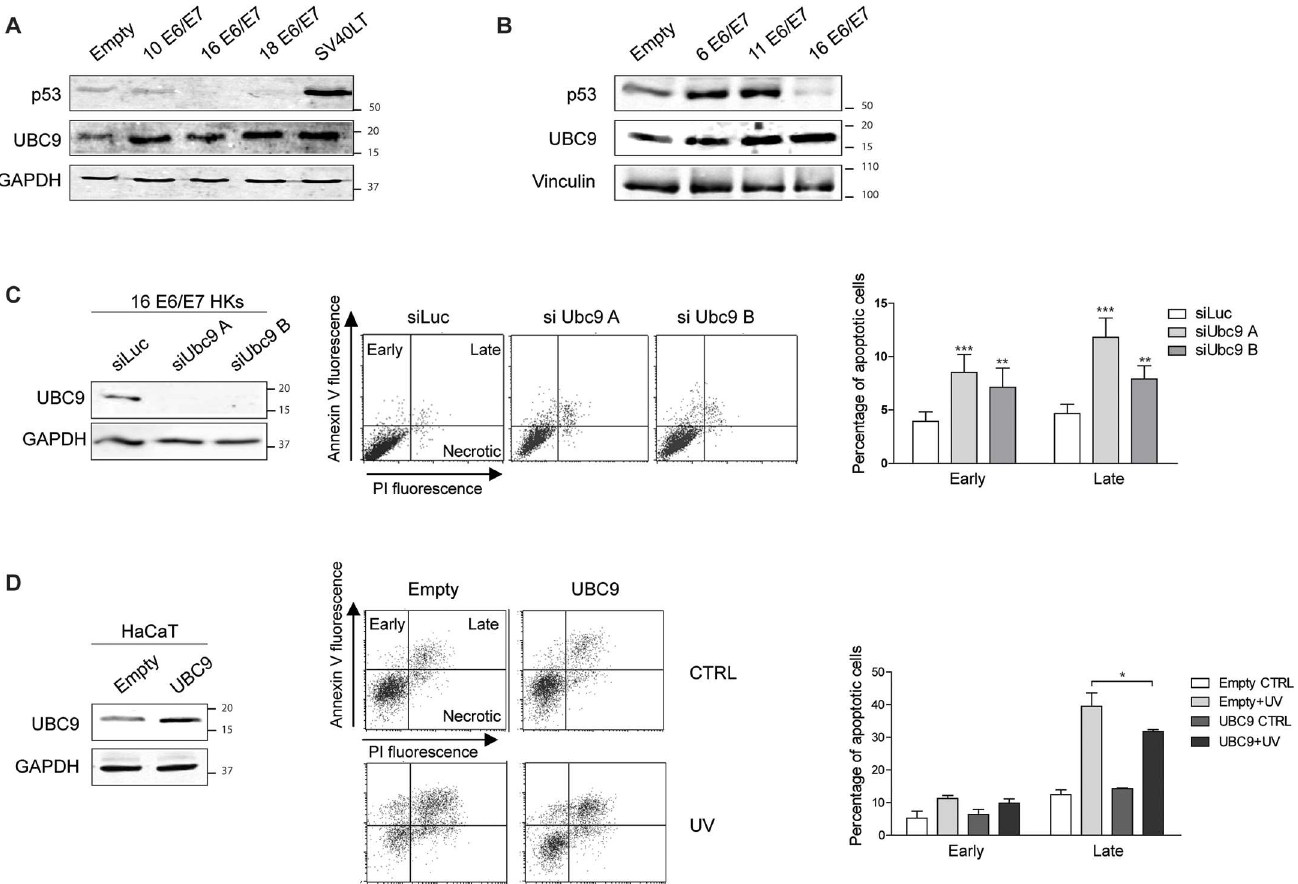
Fig 4. Transforming viral proteins similarly up-regulate UBC9 expression to extend keratinocytes life-span. (A) and (B). Left: Representative WB of HKs transduced with HPV E6/E7 from the indicatedHPV types or SV40 large T antigenrecombinant retroviruses. n = 4 different biological replicates. p53 accumulation is reportedto check SV40 large T antigenexpression. (C) Left: Representative WB analysisof HPV16 E6/E7 HKs after transfectionwith scramble (siLuc) or two different Ubc9 siRNAs. Middle:Representative cytometric dot plot of AnnexinV/PI stainingof siLuc or siUbc9s HPV16 E6/E7 HKs. y axes: AnnexinV-FITC staining;x axes: PI staining.Quadrants of early, late and necrotic cells are reported. Right: Flow cytometric analysisof siLuc or siUbc9scells apoptosis.Data are expressedas percentageof early and late apoptoticcells. Bars represent means ± SEM of n = 10 different biologicalreplicates. ** P < 0.001; *** P < 0.0001(two-way ANOVA followedby Bonferroni post hoc test) comparedto siLuc cells. (D) Left: Representative WB analysisof HaCaT cells after transfectionwith control (empty) or UBC9 protein. Middle: Representative cytometric dot plot of AnnexinV/PI staining of empty or UBC9-HaCaT. y axes: AnnexinV-FITC staining;x axes: PI staining.Quadrants of early, late and necrotic cells are reported. Right: Flow cytometric analysisof empty or UBC9-HaCaT apoptosis.Data are expressedas percentageof early and late apoptoticcells. Bars representmeans ± SEM of n = 4 different replicates. * P < 0.05; (two-way ANOVA followedby Bonferroni post hoc test) comparedto empty